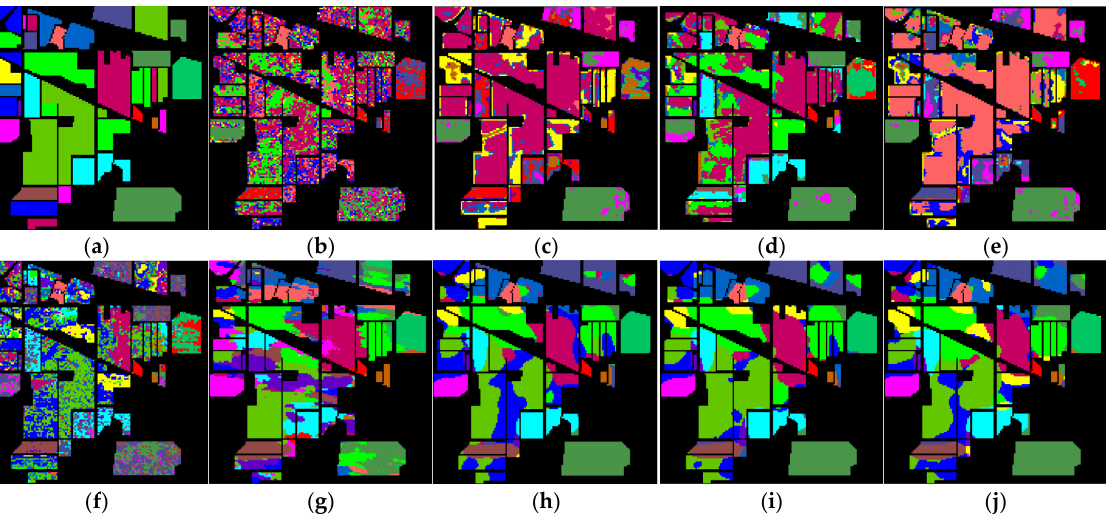
Figure 7. Classification maps resulting from nine different methods for the IP data set with three labeled samples per class. ( a ) Ground-truth. ( b ) Semi-1D CNN (16.32%). ( c ) 3D FCN (21.79%). ( d ) Semi-3D CNN (41.64%). ( e ) 3D CNN (17.78%). ( f ) 1D RNN (34.37%). ( g ) HybridSN (47.51%). ( h ) 3DCSN (61.20%). ( i ) MDSN (63.51%). ( j ) 3D-FHOG + MDSN (66.42%).